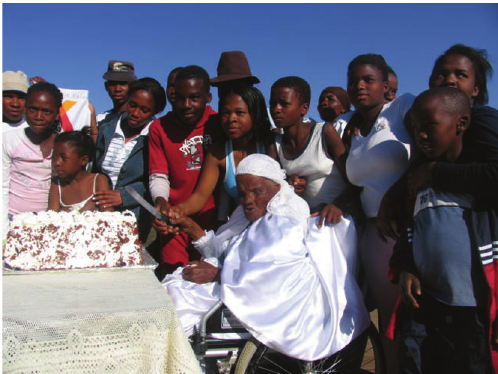
Figure 1: Moloko Temo of South Africa at what was announced as her 134th birthday. Photo with permission from the Department of Health and Social Development, Limpopo Provincial Government, South